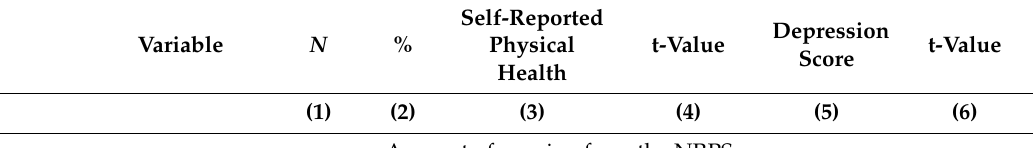
Table 3. Self-reported physical health and depression scores with di ff erent